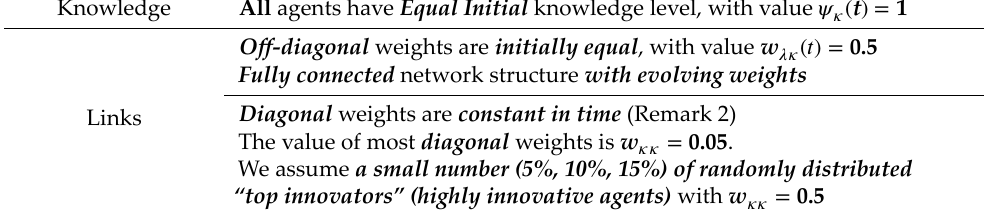
Table 2. Initial network setting.